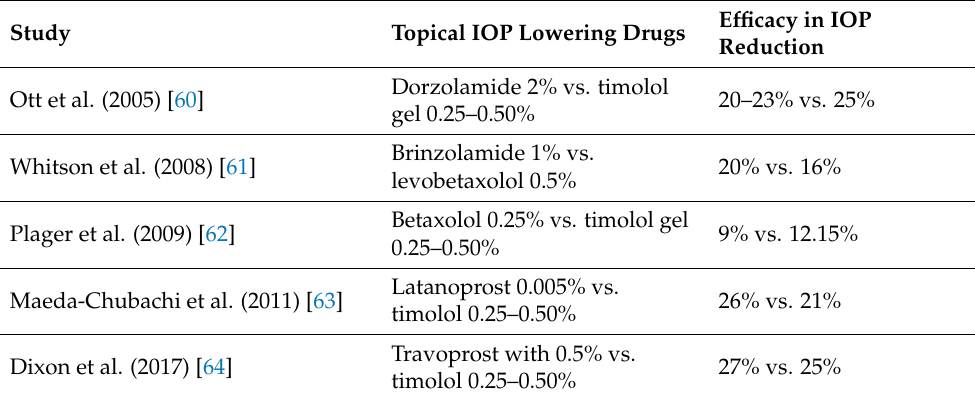
Table 3. Main RCTs for medical treatment in pediatric